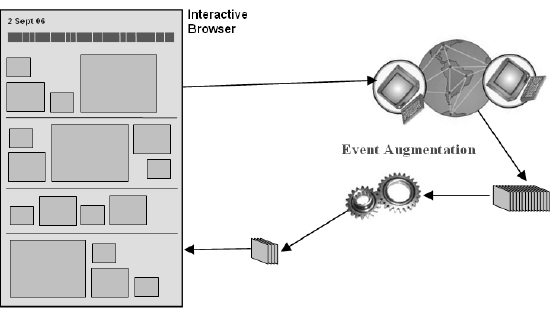
Figure 2. Augmenting lifelog events with images from external sources of